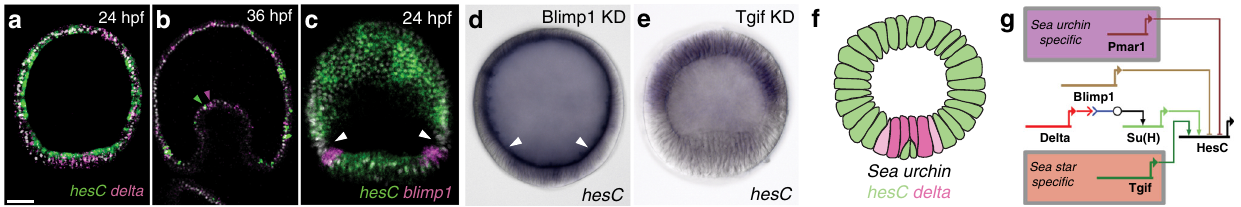
Fig. 1 Sea star hesC is positively regulated downstream of the mesoderm kernel and is co-expressed with delta . Sea star hesC and delta transcripts are co-expressed in the vegetal mesoderm ( a ) until mid-gastrula stage ( b ), or 36 hours post fertilization (hpf). Sea star hesC and blimp1 are expressed in partially non-overlapping domains during blastula stage ( c ) and morpholino knockdown (KD) of blimp1 results in an expansion of the expression domain of hesC ( d ). Morpholino knockdown of sea star Tgif produces a mesoderm-speci fi c decrease in hesC expression ( e ). Schematic showing non-overlapping expression domains of sea urchin hesC and delta transcripts at blastula stage ( f ). Regulatory inputs to the hesC gene that are speci fi c to sea urchin embryos, sea star embryos, and those that are common to both ( g ). Data shown are double fl uorescent WMISH showing both hesC expression (green) and either expression of delta or blimp1 (magenta) ( a – c ) and colorimetric WMISH ( d , e ). Data are representative of two biologically independent experiments consisting of at least ten embryos each. Scale bar represents 50 μ m; applicable to all images in the panel.